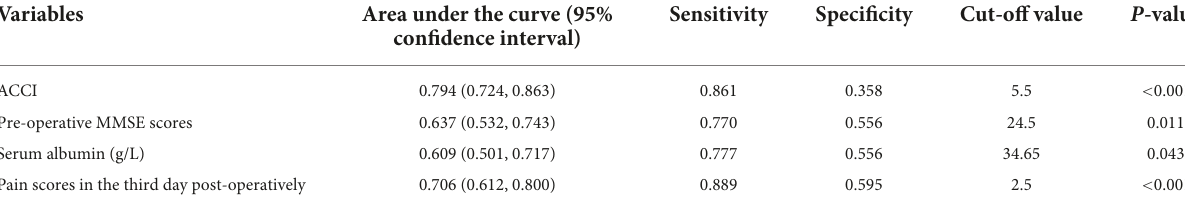
TABLE 4 The accuracy of risk factors to predict post-operative delirium (POD) by ROC curve